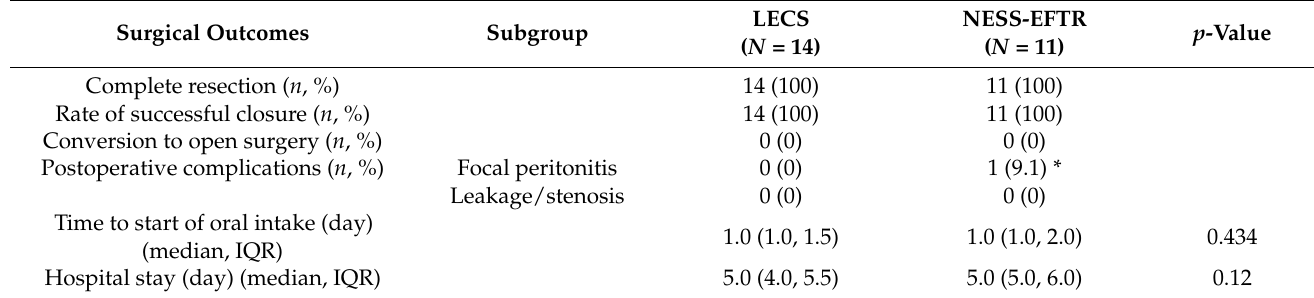
Table 3. Surgical